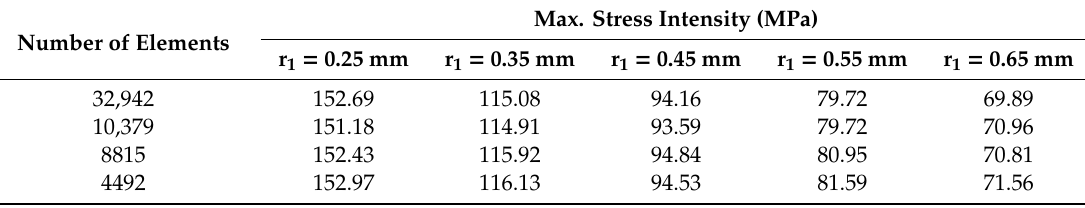
Table 4. Maximum stress intensity on the di ff erent maximum mesh element sizes at the di ff erent additional elliptical channel radii (r 1